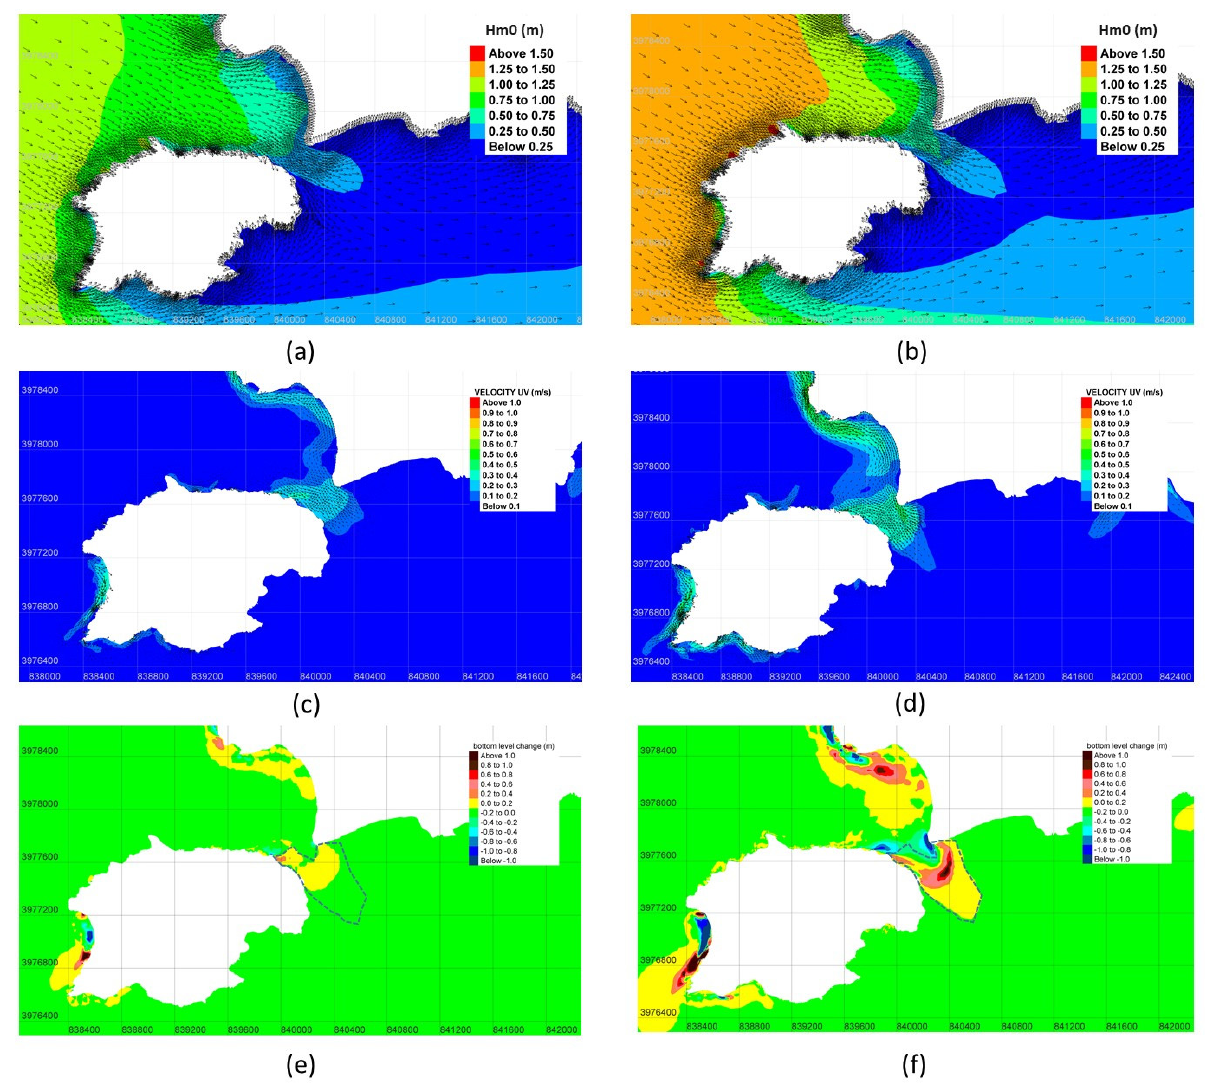
Figure 16. Maps of Hm0 (m), current velocity (m/s), and bottom level change (m) in the sea area of interest for wind-wave scenario 1 ( a , c , e ) and for wind-wave scenario 2 ( b , d , f ), respectively. The dotted closed line encloses the active domain of the study area for tombolo formation. Maps created in Blue Kenue™ software tool for hydraulic modellers.